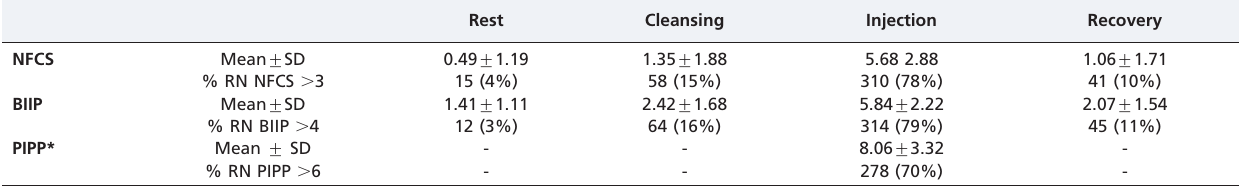
Table 1 - Pain scale scores (NFCS, BIIP and PIPP) for the 4 studied time periods.